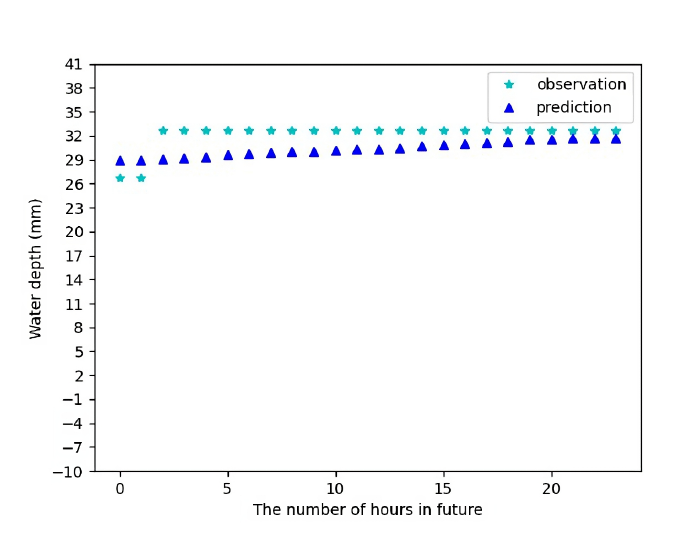
Figure 9. Water depth forecast for Sensor 1 for 24 h in future.